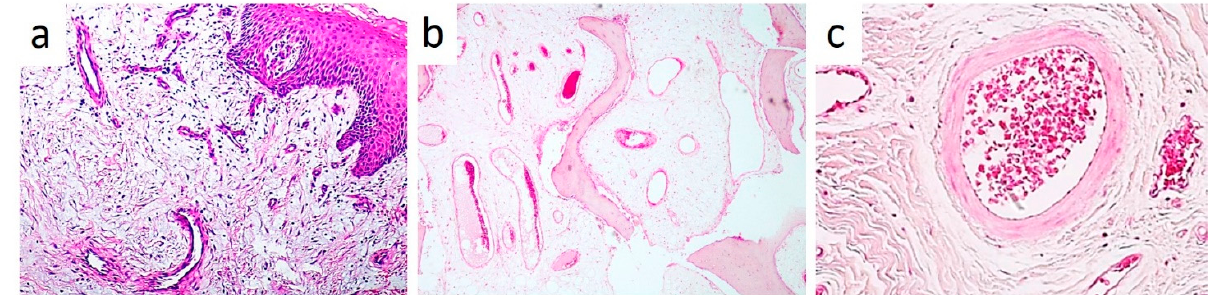
Figure 4. ( a ) Clinical appearance after diode laser trans-mucosal photocoagulation: the lesion appears light reddish in color and reduced in size. ( b ) Clinical appearance immediately after the second diode laser treatment: the lesion shows grey-yellowish discoloration. ( c ) Intra-operative view after surgical removal: bone erosion with regular bleeding is evident, mimicking a periodontal defect.